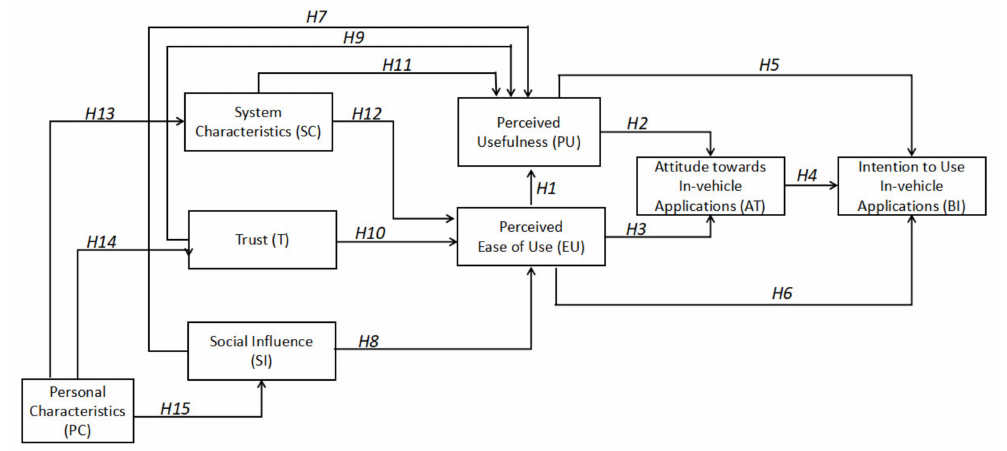
Figure 2. Research